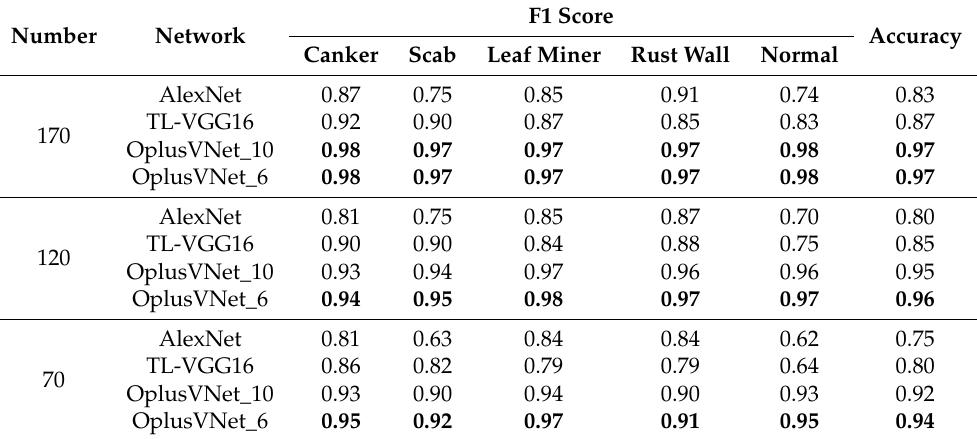
Table 6. Experimental results of different network models in different small training